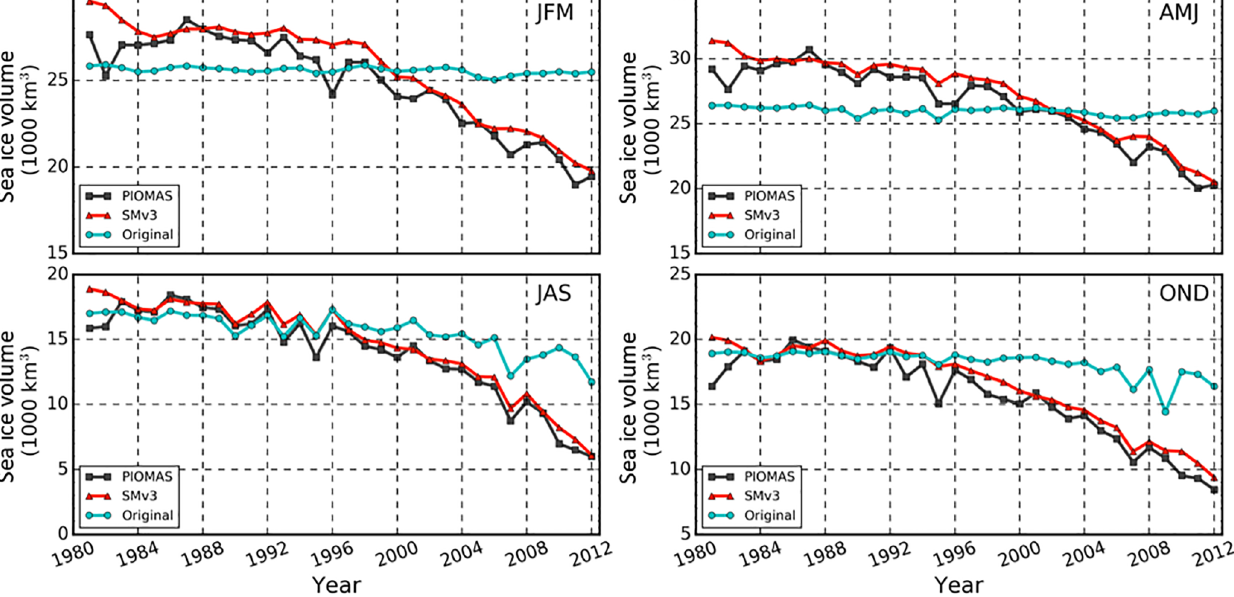
Figure 16. Time series of seasonally averaged sea ice volume over the period 1981–2012, in units of 10 3 km 3 for the PIOMAS sea ice thickness analysis (which assimilates observations) (black), the SMv3 statistical model of Dirkson et al. (2017) (red), and CanSIPS initial conditions (cyan). The CanSIPS system as originally configured incorporates no information about recent sea ice thinning and thus misses the recent downward trends of sea ice